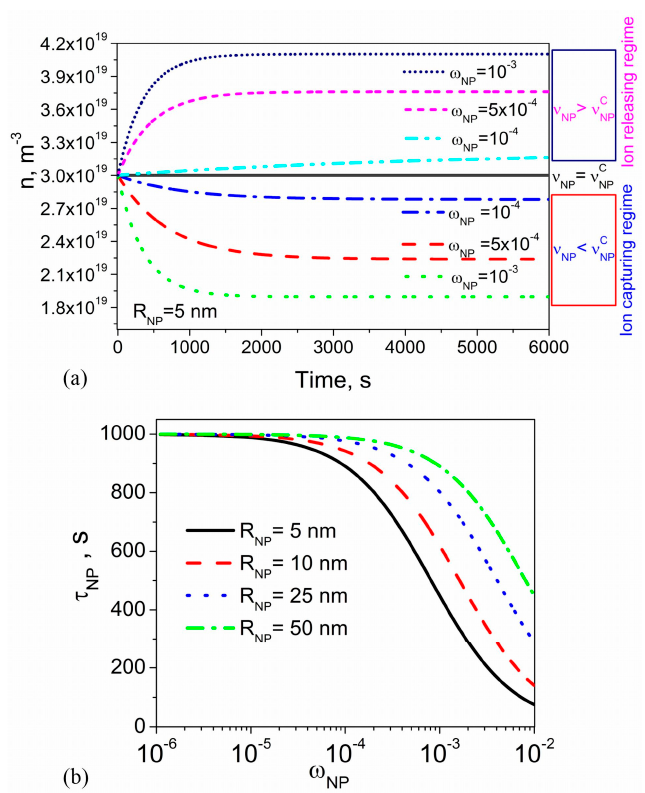
Figure 1. ( a ) The volume concentration of mobile ions n versus time calculated using different values of the weight concentration of nanoparticles ω NP and their contamination factor ν NP ( v NP = 10 − 4 (dotted, dashed, and dotted-dashed curves); v NP = 3 × 10 − 4 (solid curve); v NP = 5 × 10 − 4 (dashed-dotted-dotted, short-dashed, and short-dotted curves)). The radius of nanoparticles R NP is 5 nm; ( b ) The time constant τ NP as a function of the weight concentration of nanoparticles ω NP calculated at different values of the nanoparticle radius R NP ( R NP = 5 nm (solid curve); R NP = 10 nm (dashed curve); R NP = 25nm (dotted curve); R NP = 50 nm (dashed-dotted curve)). Other parameters used in simulations: K NP = 10 − 23 m 3 , k NP